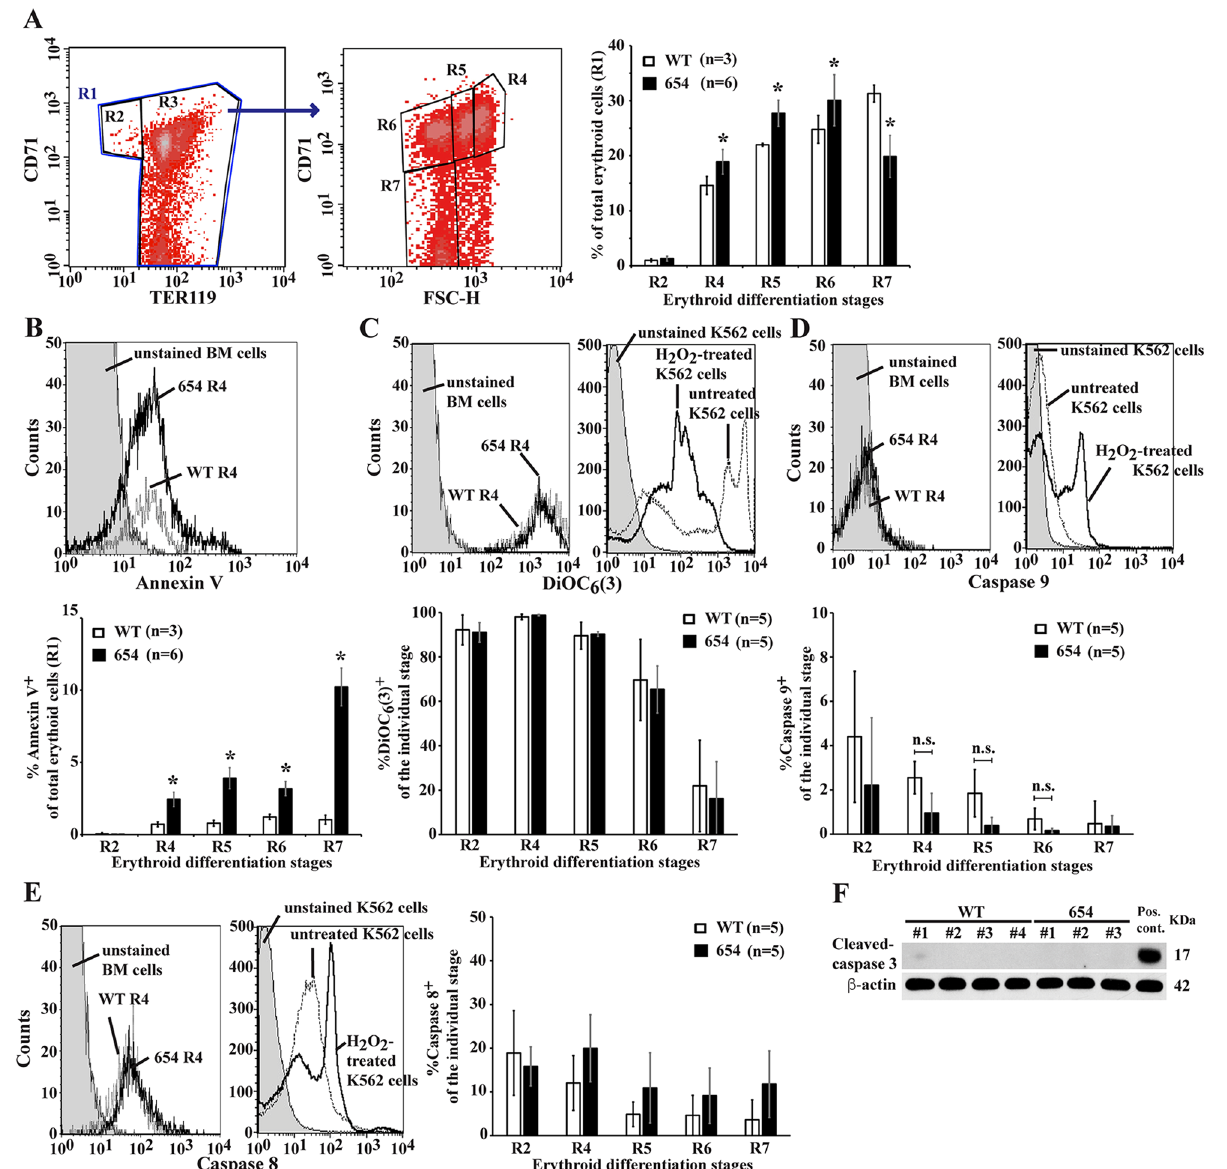
Figure 1. Elevated PS-bearing basophilic erythroblasts with no increased apoptosis in β-thalassaemic mice. Apoptotic markers were examined in bone marrow erythroid cells from β-thalassaemic mice (654) and wild type mice